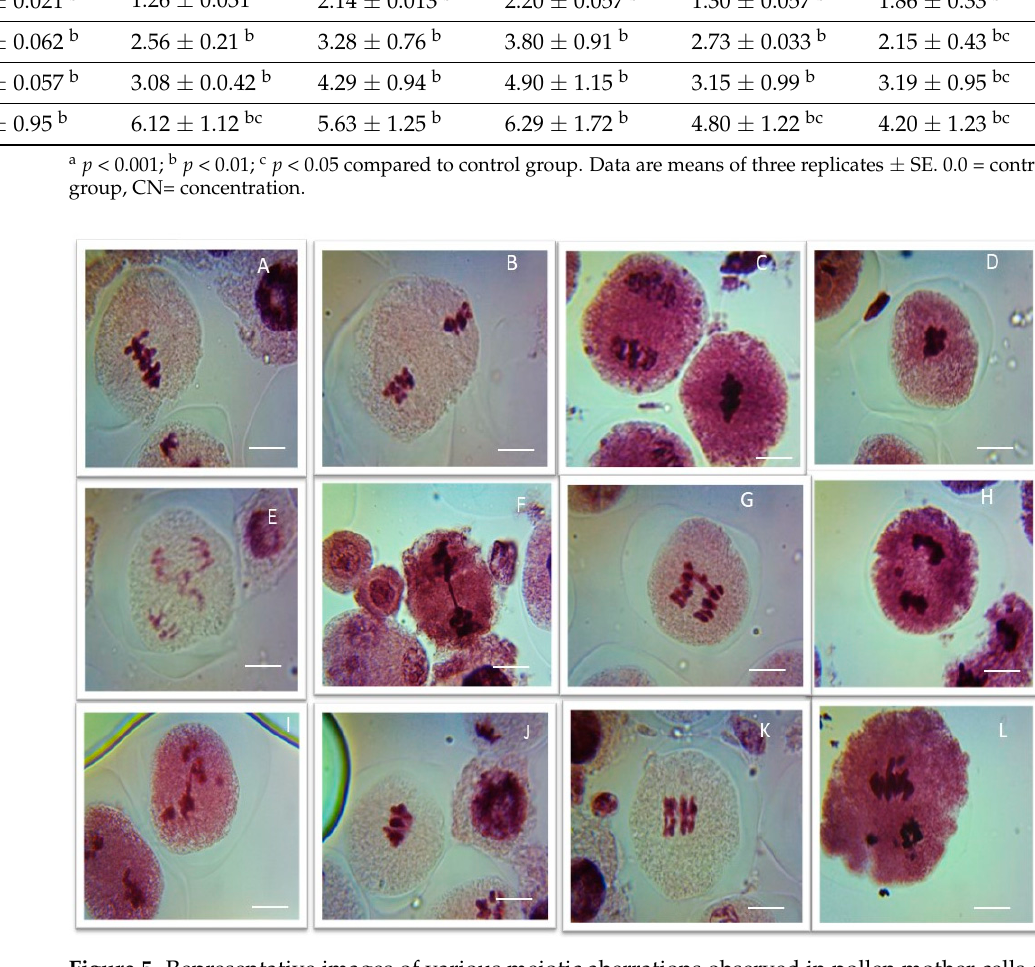
Figure 5. Representative images of various meiotic aberrations observed in pollen mother cells of methomyl (ME) and Imidacloprid (IM) exposed P. sativum seeds. ( A , B ) Clumped nuclei (CNU) at metaphases I and II; ( C , D ) stickiness (STC) at metaphases I and II; ( E – G ) bridges (BR) at anaphases I and II; ( H , I ) laggards (LG) at anaphases I and II; ( J , K ) secondary association (SA) at metaphases I and II; ( L ) precocious separation (PS) at anaphase II; Scale bars = 10 μ m In plants treated with ME for 6 h, the percentage of aberrant metaphases I and II and anaphases I and II increased with an increase in the concentration of ME. At a 0.1% con- centration, common aberrations were CNU (1.56%), LG (0.81%), SA (3.56%), and PS (1.67%) in comparison to the control group. Meanwhile, a 0.2% to 0.5% increase in the concentration resulted in a very significant increase ( p < 0.01) in the number of aberrant cells. The maximal number of aberrant cells was found at a concentration of 0.5%, namely, CNU (9.76%), STC (9.51%), BR (12.11%), LG (12.11%), SA (13.05%), and PS (10.44%), com- pared to the control group. In plants treated with IM for 1 h, the percentage of aberrant metaphases I and II and anaphases I and II increased as the concentration of IM increased. At the lowest concen- tration (0.1%), no chromosomal aberrations were found; at 0.2%, aberrations were CNU (0.67%), BR (0.77%), LG (0.98%), and PS (0.80%) in comparison to the control group. A further increase in the IM concentration from 0.3% to 0.5% resulted in a very significant increase ( p < 0.01) in the number of aberrant cells. The maximal number of aberrant cells was found at a concentration of 0.5%, namely, CNU (2.23%), STC (1.94%), BR (2.16%), LG (2.1%), SA (2.1%), and PS (2.3%), compared to the control.